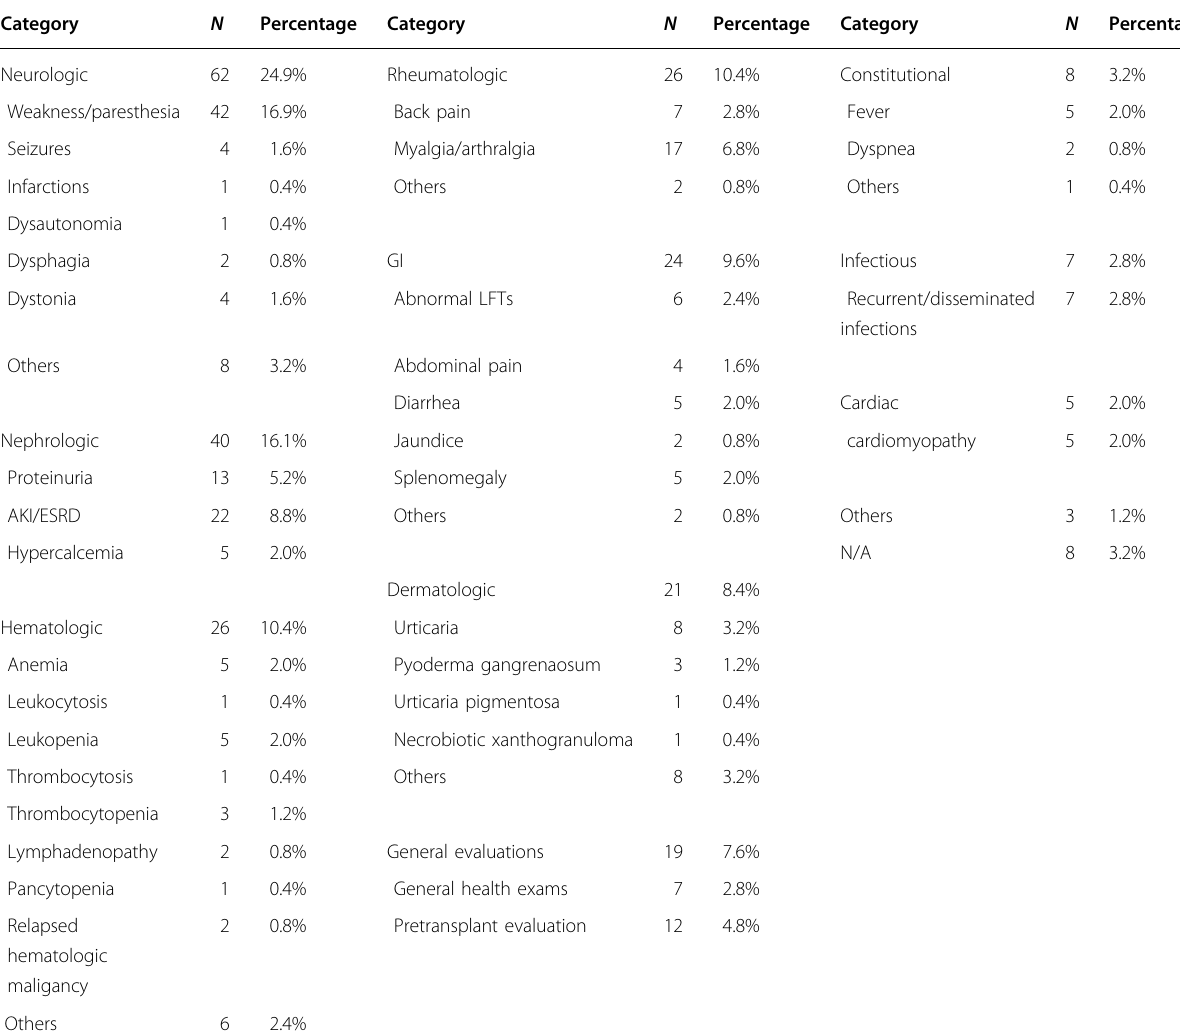
Table 3 Chief complaints for